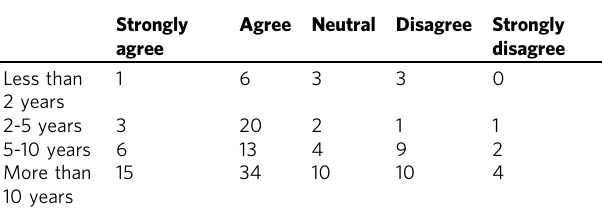
Table 2 The contingency table for Question 1 and experience level Strongly Agree Neutral Disagree Strongly agree